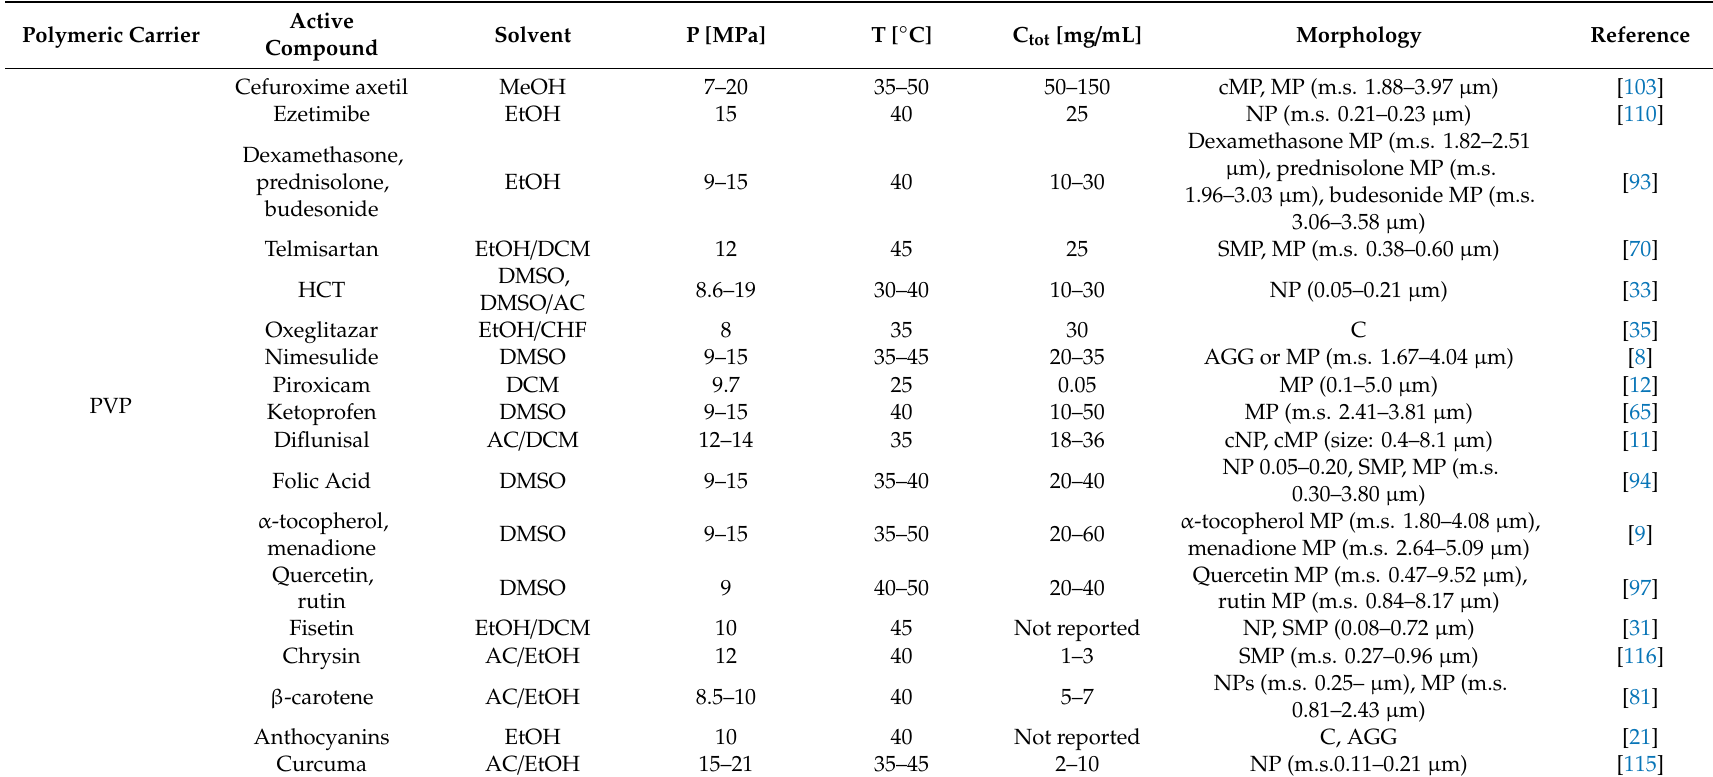
Table 2. An overview of the polymer / active compound composites obtained by the SAS technique. C: Crystals; m.s.: Mean size; c: Coalescent; NP: Nanoparticles; SMP: Sub-microparticles; MP: Microparticles; EMP: Expanded microparticles ( balloons ); AGG: Aggregates; AC: Acetone; CHF: Chloroform; DCM: Dichloromethane; DMF: Dimethylformamide; DMSO: Dimethylsulfoxide; EtOH: Ethanol; EtAc: Ethyl acetate; MeOH: Methanol; NMP: N-methyl-2-pyrrolidone; THF: Tetrahydrofuran; PVP: Poly(vinylpyrrolidone; MCC: Microcrystalline cellulose; β -CD: β -Cyclodextrin; HP- β -CD: Hydroxypropyl- β -cyclodextrin; PLA: Polylactic acid; PCL: Poly( ε -caprolactone); PLGA: Poly(lactide-co-glycolide); PLLA: Poly(L-lactic acid); PEG: Poly-ethylene glycol; mPEG-PLLA: Methoxy poly(ethylene glycol)-b-poly(L-lactide); HPMC: Hydroxypropylmethyl cellulose; HPC: Hydroxypropyl cellulose; HCO-60: Polyoxyethylene (60) hydrogenated castor oil; CAP: Cellulose acetate phthalate; PHBV: Poly(hydroxybutirate-co-hydroxyvalerate); PVM / MA: Polymer poly(methyl vinyl ether-co-maleic anhydride); PMMA: Poly(methyl methacrylate; HCT: Hydrochlorothiazide; HCPT: 10-Hydroxycamptothecin; 17 α -MT: 17 α -Methyltestosterone; PZA: